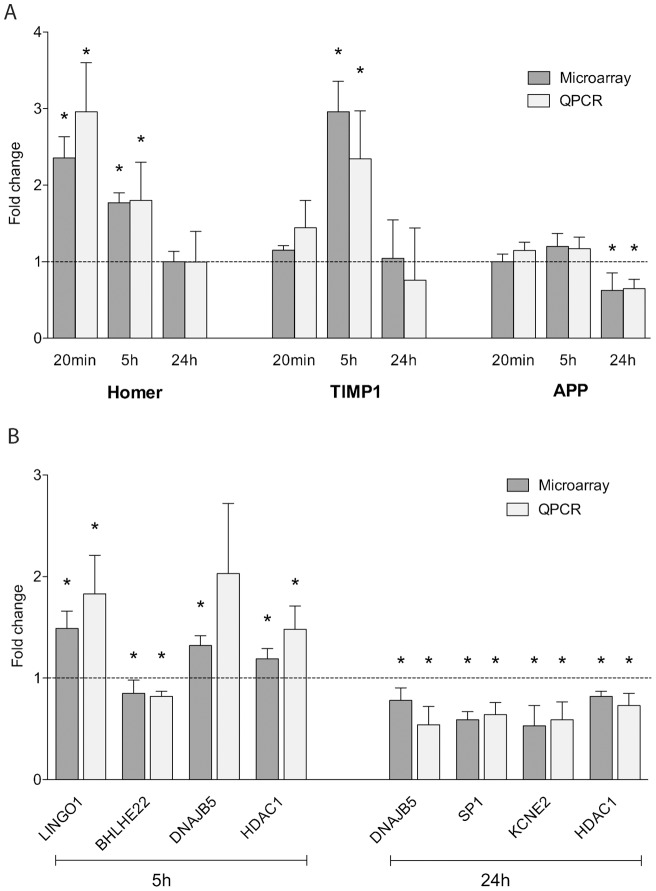
Validation of differentially expressed genes by quantitative PCR (qPCR).Differential expression of selected genes was validated by qPCR. (A) Genes previously reported to be LTP-regulated: HOMER, homer homolog 1; TIMP1, tissue inhibitor of metalloproteinase 1; APP, amyloid precursor protein. (B) Novel LTP-regulated genes: LINGO1, leucine rich repeat and Ig domain containing; SP1 specificity protein 1; BHLHE22, basic helix-loop-helix family, member e22; HDAC1, histone deacetylase 1; KCNE2, potassium voltage-gated channel, Isk-related family, member 2 and DNAJB5, DnaJ (Hsp40) homolog, subfamily B, member 5. Results are expressed as mean fold change ± SEM. *p≤0.05, Student's t-test (n = 5–9). qPCR samples were normalised to the housekeeping gene HPRT using the 2− ΔΔCT method.